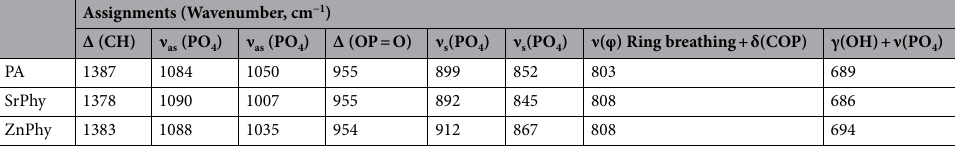
Table 2. Signal assignments of Raman spectra for PA, SrPhy and ZnPhy.